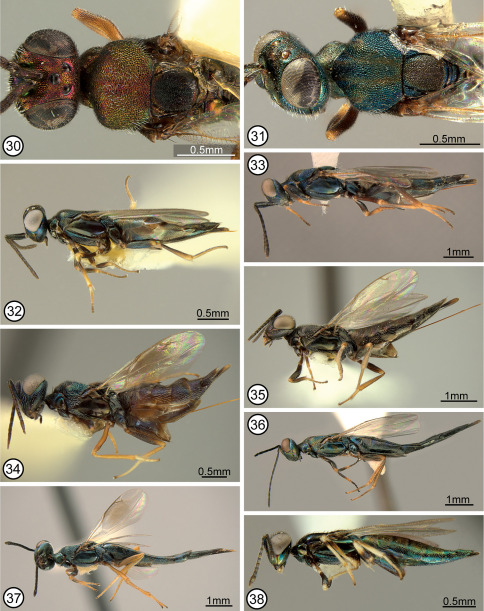
30−31 head and dorsal mesosoma ♂: 30 Calosota bicolorata (allotype) 31 Calosota longiventris (23) 32−38 lateral ♀ habitus: 32 Calosota vernalis (43) 33 Calosota aestivalis (16) 34 Calosota bicolorata (holotype) 35 Calosota longivena (holotype) 36 Calosota elongata (24) 37 Calosota longiventris (21) 38 Calosota albipalpus (7). Numbers in parentheses = CNC Photo 2009-no.